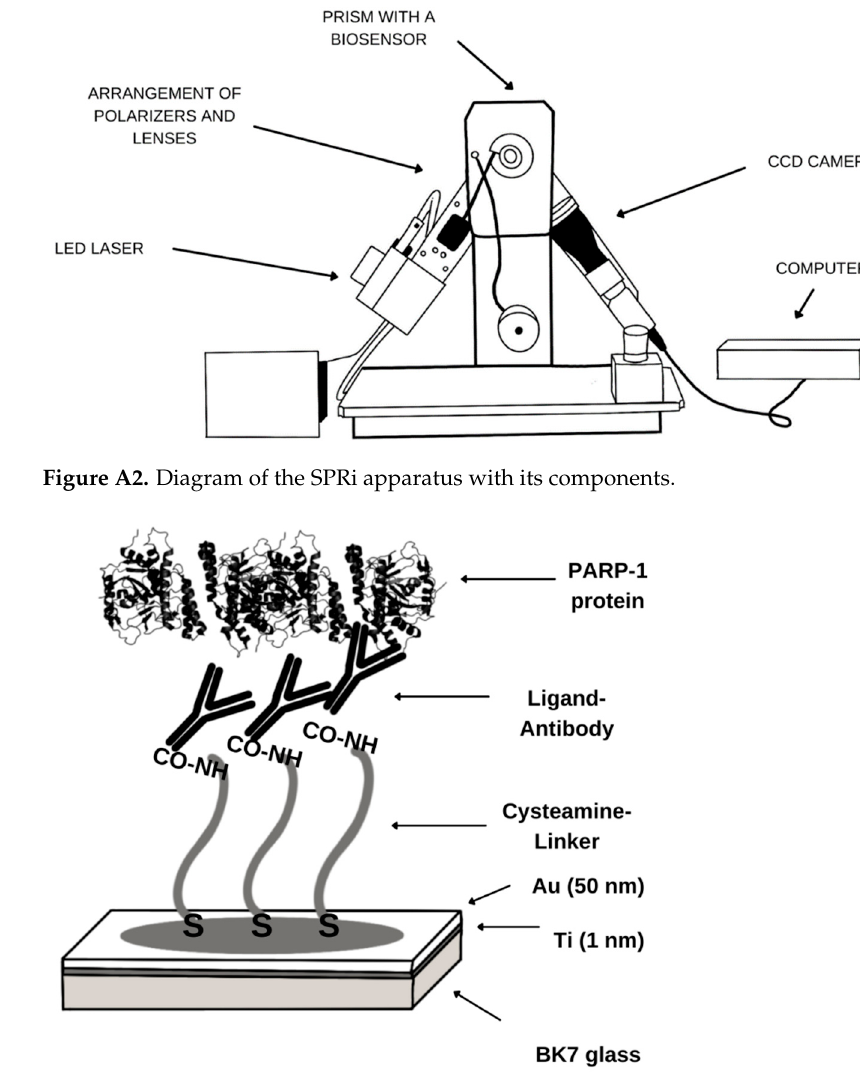
Figure A3. Diagram of the biosensor structure.